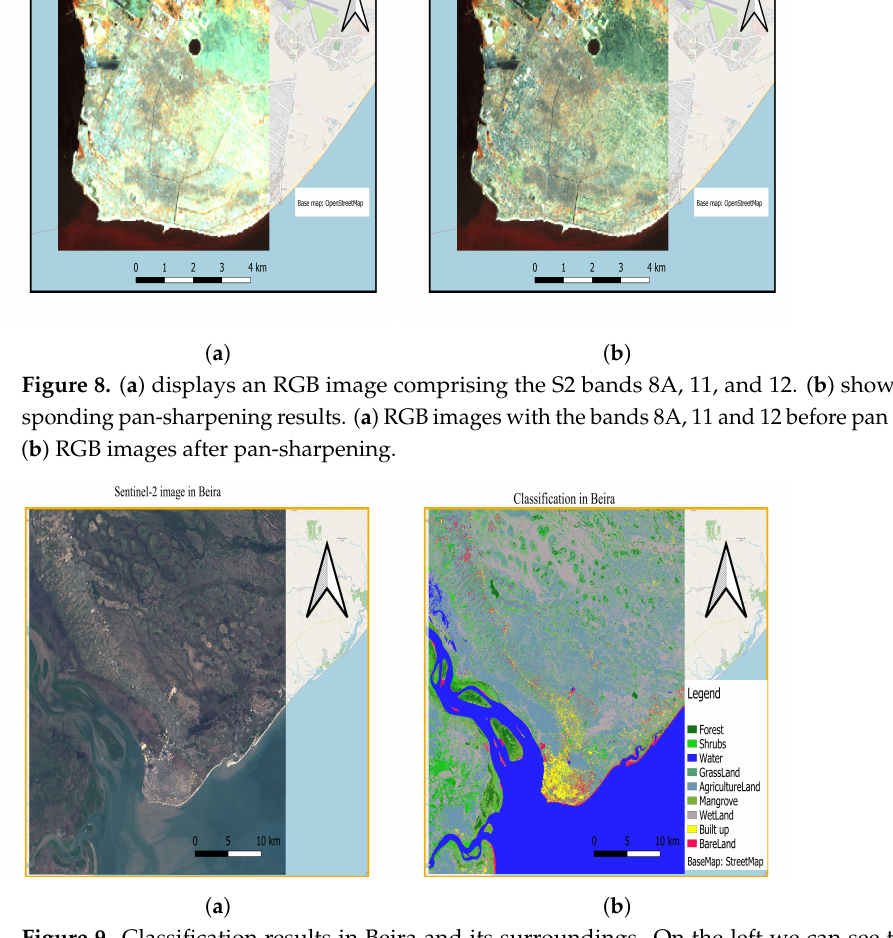
Figure 9. Classification results in Beira and its surroundings. On the left we can see the original image and on the right the respective classification results. ( a ) S2 image, 2 December 2018. ( b ) Classi- fication